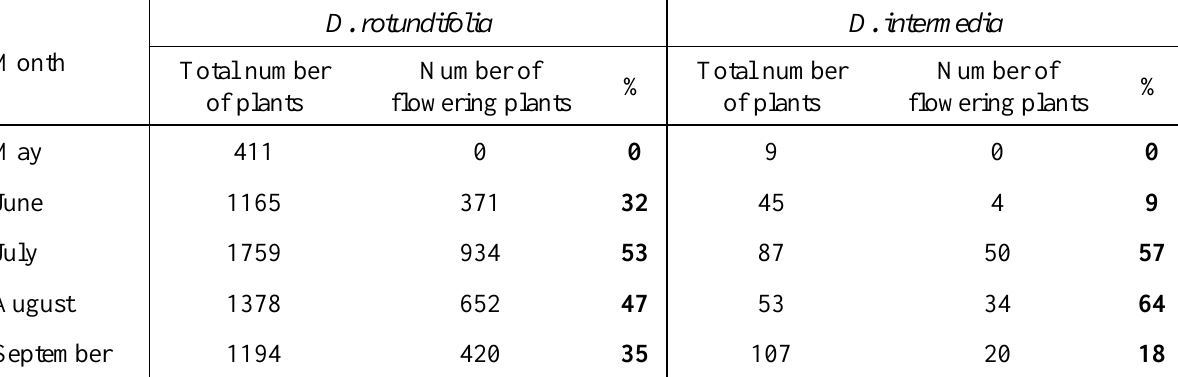
Table 4. Percentage of flowering plants amongst all (flowering and non-flowering) Drosera plants collected from all plots in different months. Harvest dates: June–September 2013 and May–September 2014 ( n = 23; 2013: 2 plots × 4 months; 2014: 3 plots × 5